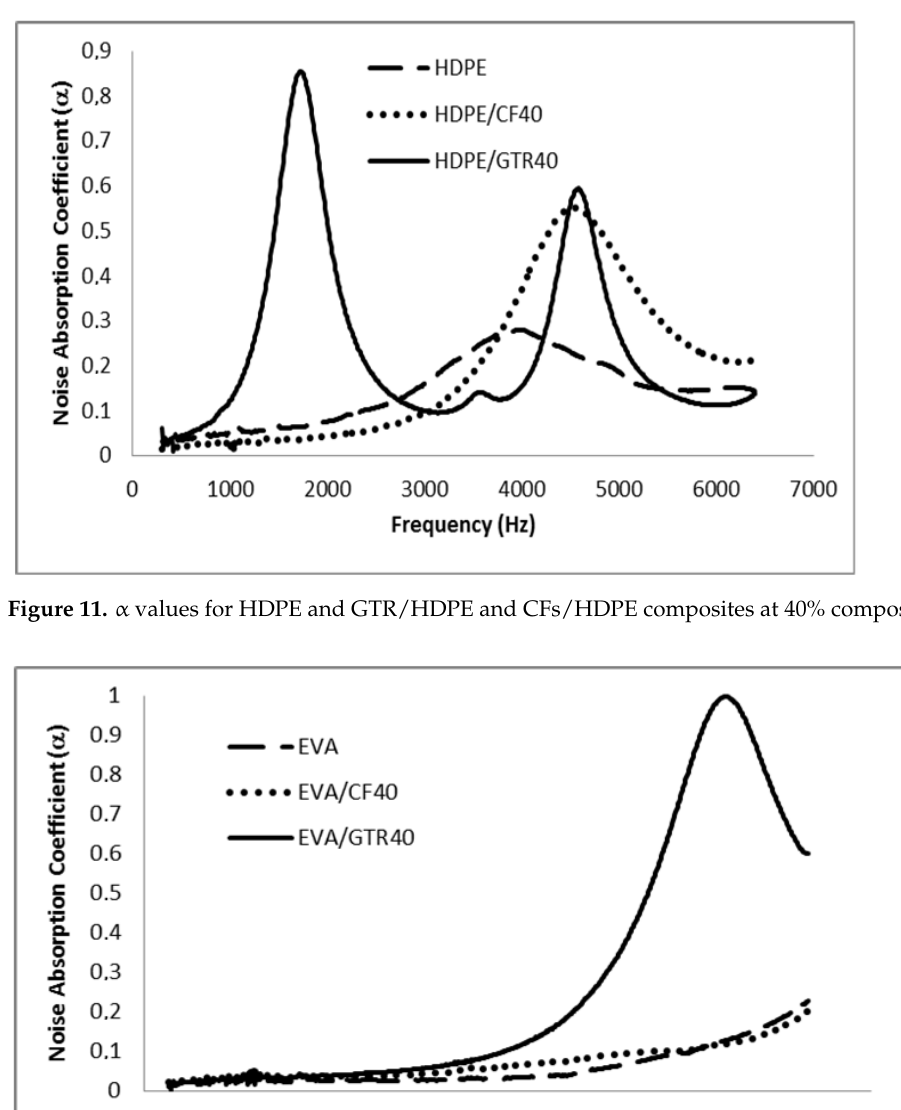
Figure 13. α values for PP and GTR/PP and CFs/PP composites at 40 % composition. To know why the composite reinforced with GTR has better acoustical properties than the composite reinforced with CFs, we can observe that the composite reinforced with GTR has more crazes, holes and is more porous than composites reinforced CFs. This is due mainly to the morphology of the reinforcement since GTR has an irregular polyhe- dron geometry with flat faces, straight edges and sharp corners, meanwhile CFs have a fibrous morphology with a smooth surface. This kind of morphology allowed the for- mation of holes, porous and crazes between them and between GTR and matrix. To ex- plain this behavior, a model was used defined as “rigid - framed porous materials” [32]. This model considers that the cavity walls are non-deforming, and the increase in acoustic absorption takes place due to the viscous losses and thermo-elastic damping where the sound propagates through a large number of air cavities in the composite. The sound